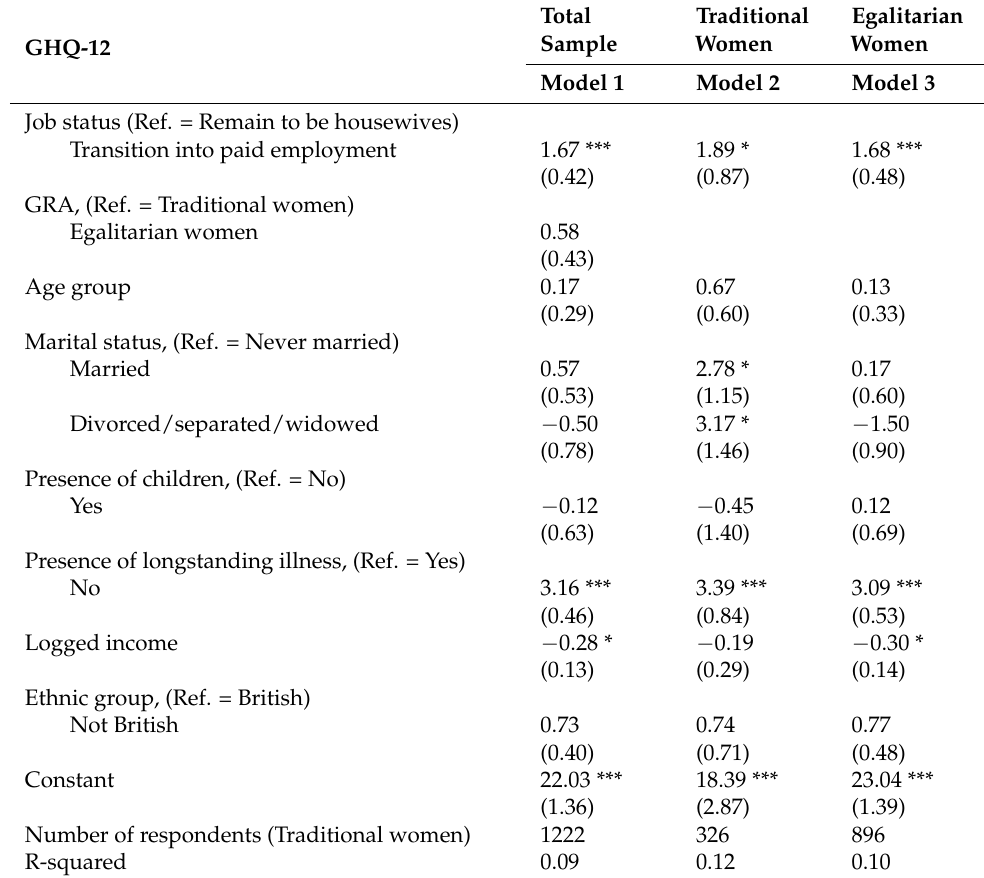
Table A1. Ordinary least squares (OLS) regressions predicting the impact of transitioning from